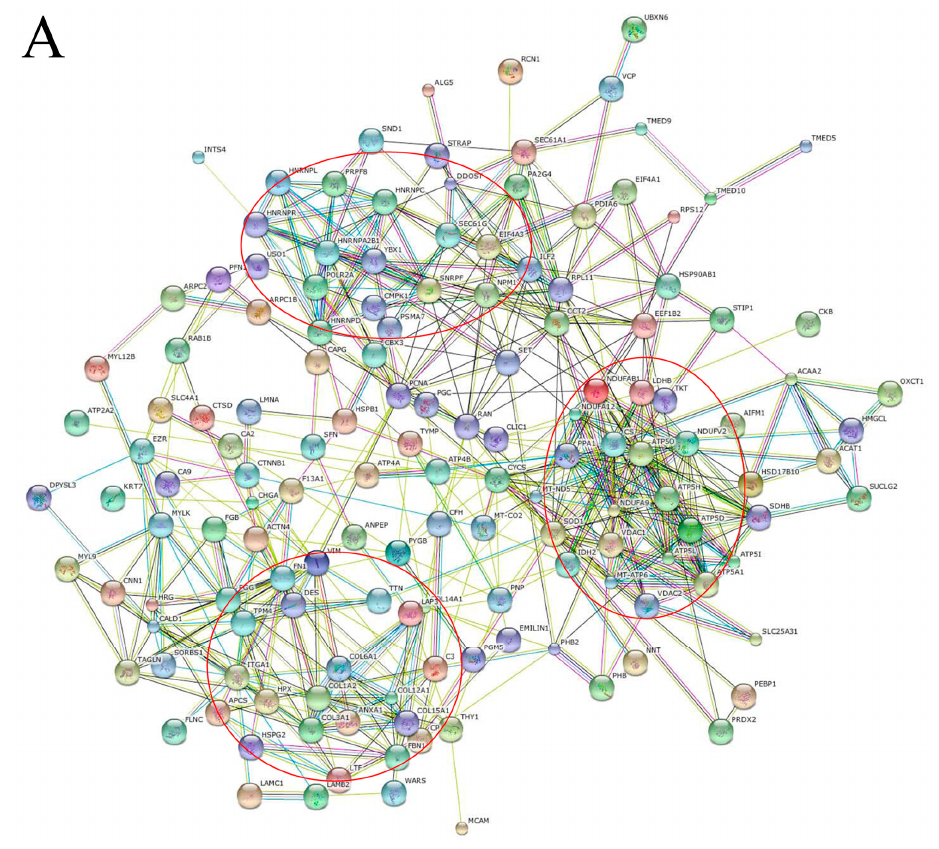
Figure 4. Cont. Figure 4.